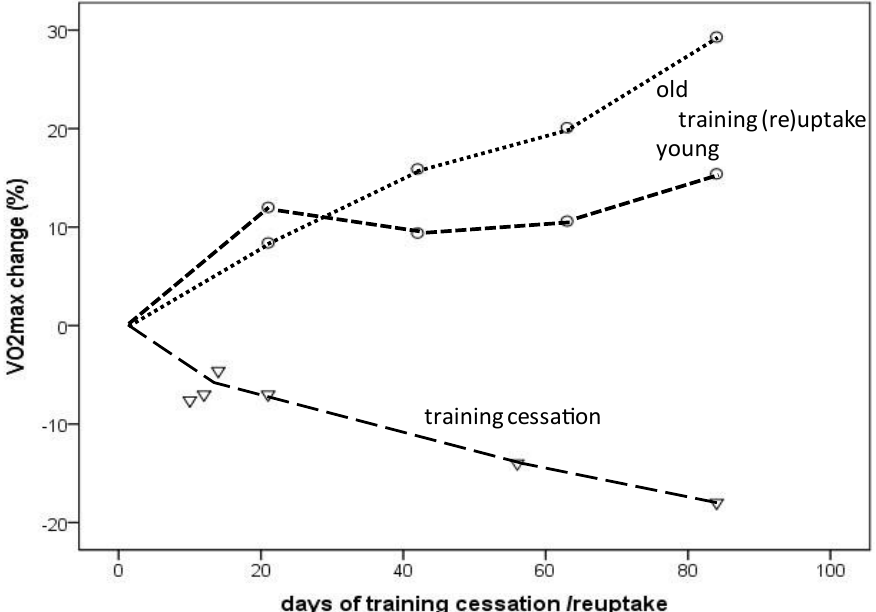
Figure 2. VO 2 max change depending on the amount (days) of training cessation (triangles) or training (re)uptake (circles: dotted line indicates older individuals; dashed line indicates young individuals) (from selected longitudinal data [22,24,28,31] presented in Table 2).